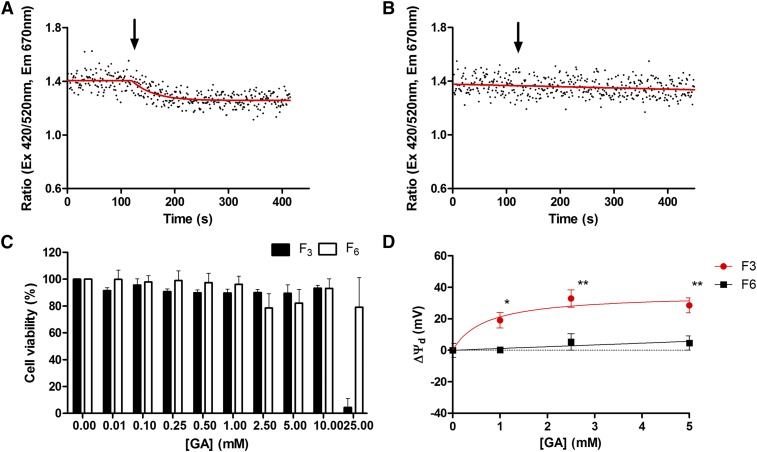
The interaction of F3 and F6 with neuronal cells. Addition (black arrows) of 5 mM F3 (A), but not 5 mM F6 (B), induced a reduction in the di-8-ANEPPs fluorescence ratio indicative of a reduction in the membrane dipole potential. C: Immortalized neuronal cell cultures were incubated in the presence of varying concentration of F3 or F6 for 24 h before cell viability was assessed using an AlamarBlue assay. No significant change in cell viability was observed on addition of up to 10 mM concentrations of either agent. D: The change in membrane dipole potential induced on addition of F3 or F6 to immortalized neuronal cells labeled with di-8-ANEPPs. Profiles were fit to a simple hyperbolic equation or straight line and the best fitting model determined by F-test, n > 3, mean ± SEM.